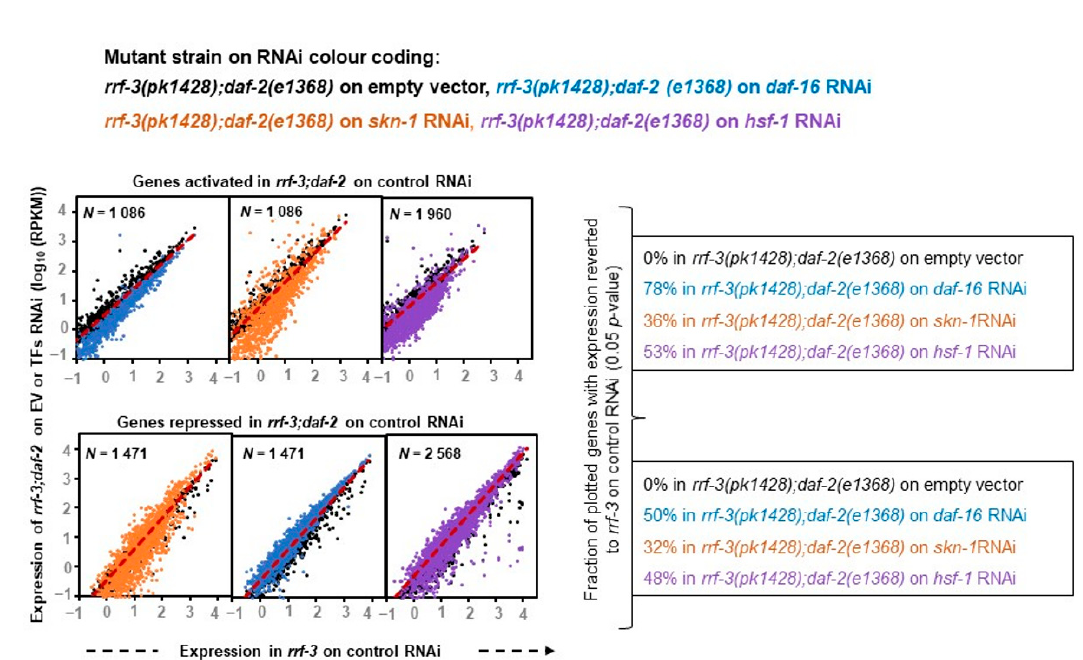
Figure 3. Distinct activator and repressor activities of TFs downstream of insulin signaling. Scatter-plots comparing gene expression (log 10 RPKM) in control ( rrf-3 mutant on empty vector) with rIIS condition ( rrf-3;daf-2 ) double mutant on empty vector) and TF knock-down conditions ( rrf-3;daf-2 ) double mutant on daf-16/skn-1/hsf-1 RNAi). Genes expressed with RPKM ≥ 10 in all comparing conditions either significantly activated (top panel) or repressed (down panel) by rrf-3(pk1426);daf-2(e1368) were considered. Colors indicate the strains on RNAi in which the gene expression was analyzed. Gene expression away from the plots’ diagonals represents significantly activated or repressed genes in the rIIS condition compared to control (black dots). The shift of genes near to the plots’ diagonals due to rrf-3;daf-2 on TFs RNAi represents the fraction of genes with expression reverted to the “control” condition. Mutant rrf-3;daf-2 on daf-16 RNAi extensively, rrf-3;daf-2 on skn-1 RNAi partially and rrf-3;daf-2 on hsf-1 RNAi marginally reverted the rIIS expression near to control levels. As indicated by the large fraction of DAF-16-dependent activation of genes suggests its predominant role as an activator, while SKN-1/HSF-1 shows a similar extent of activation and repression activities.